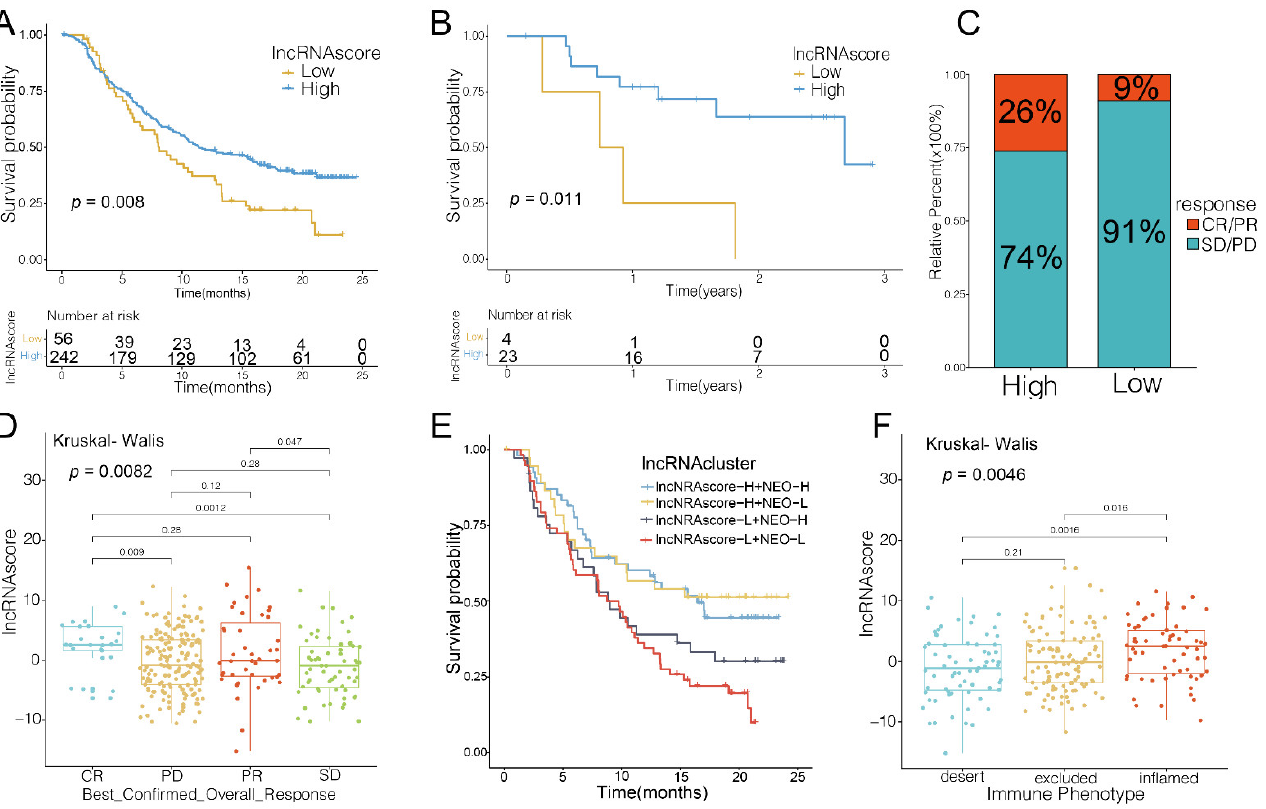
Figure 5. LncRNA score in the role of anti-PD-1/L1 immunotherapy. Kaplan–Meier curves of survival in the high and low lncRNA groups in the patients receiving ( A ) anti-PD-L1 therapy and ( B ) anti-PD-1 therapy; ( C ) Proportion of patients with response to PD-L1 blockade immunotherapy in the high and low lncRNA score groups; ( D ) Distribution of lncRNA score in distinct anti-PD-L1 clinical response groups; ( E ) Survival analyses for patients receiving anti-PD-L1 immunotherapy stratified by the combination of lncRNA score and neoantigen burden, using Kaplan–Meier curves; ( F ) Differences in lncRNA score among distinct tumor immune phenotypes in IMvigor210 cohort. SD, stable disease; PD, progressive disease; CR, complete response; PR, partial response; NEO, neoantigen burden.